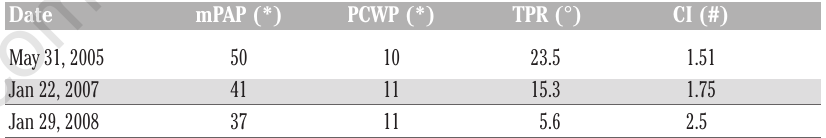
Table 1. Cardiac catheterization findings.